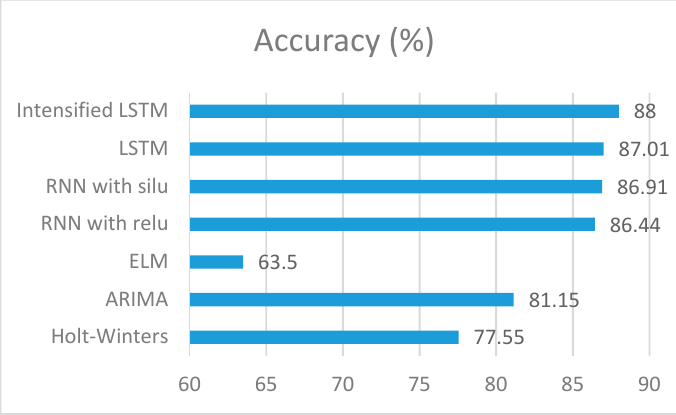
Figure 9. Comparison of accuracy for Neural Network based prediction models.